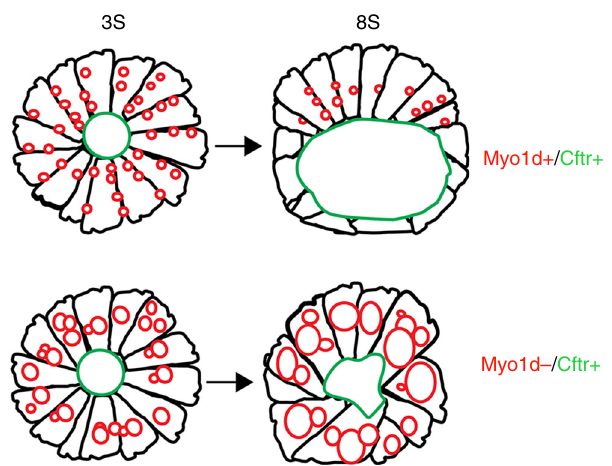
Fig. 6 myo1d functions to regulate KV lumen expansion, a key event in establishing proper laterality in zebra fi sh. A model depicting the role of Myo1d and Cftr in KV lumen expansion. When Myo1d mediated vacuole delivery and Cftr channel are active, proper AP cell morphology and threshold lumen expansion with a de fi nitive spherical shape are established by 8S. In the absence of Myo1d, despite CFTR channel being present, KV lumen fails to generate a spherical shape and proper size. This is due to the failure of vacuole traf fi cking towards apical surface of the